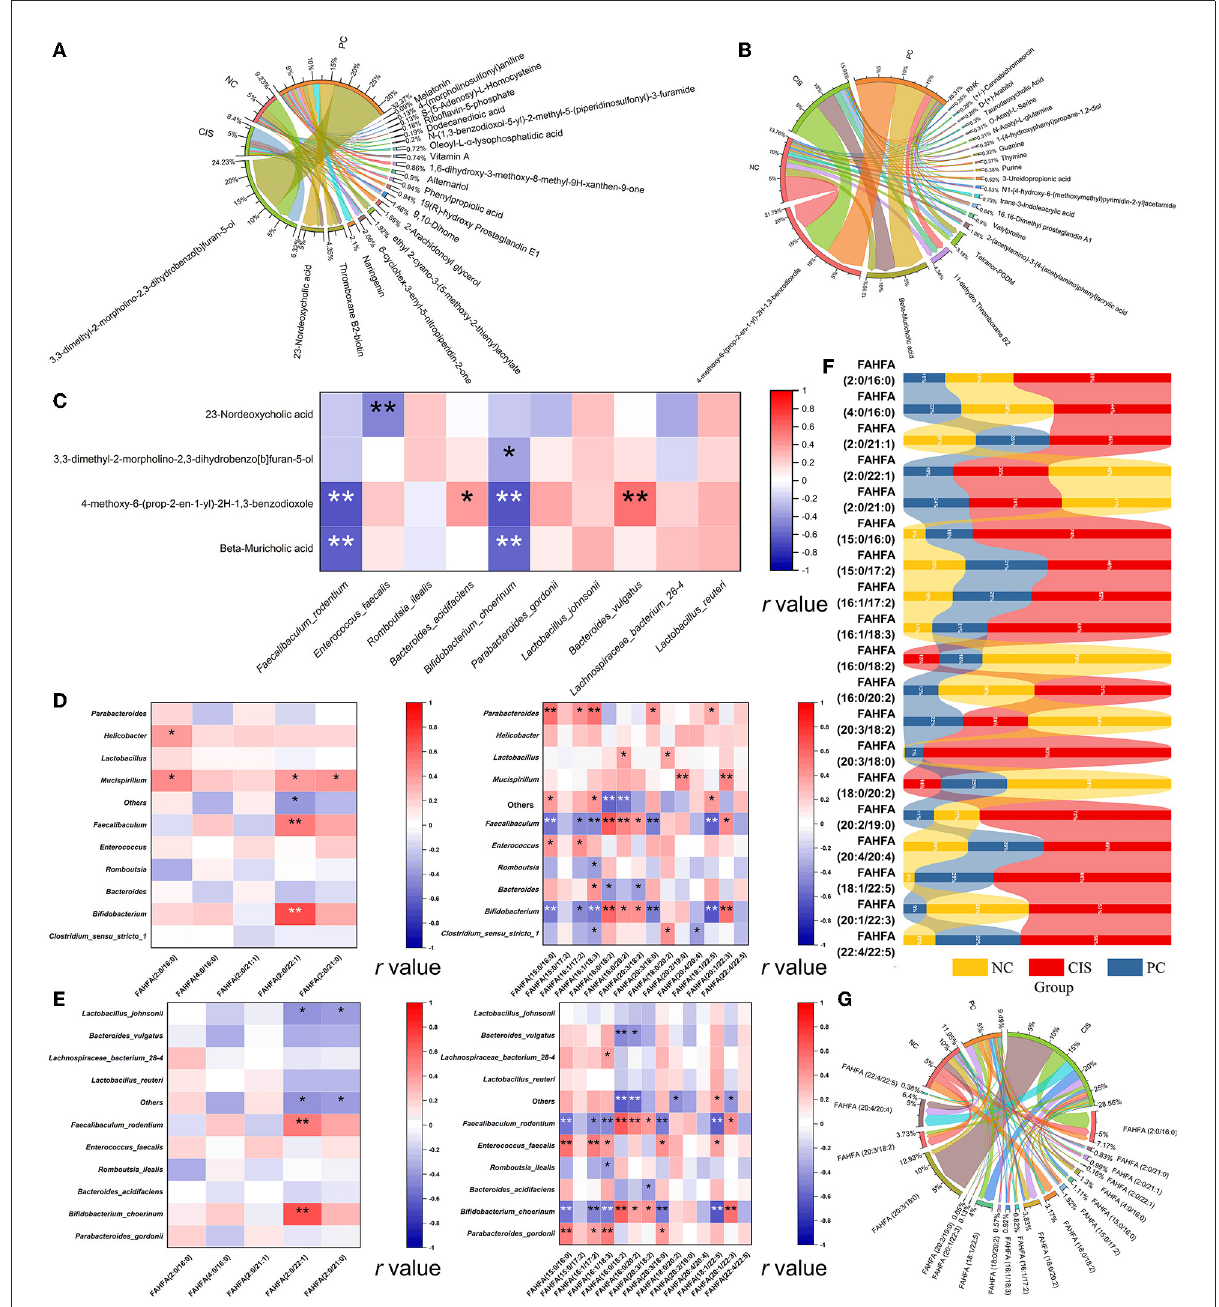
FIGURE6 Bile acid-related metabolites and FAHFAs levels in feces. (A) Chord diagram of metabolites which was significantly regulated by C-phycocyanin compared with the CIS group; (B) chord diagram of metabolites which was significantly regulated by cisplatin compared with the NC group; (C) Spearman correlation analysis between bile acid metabolites and the top 10 species abundance; (D) Spearman correlation analysis between FAHFAs contents and the top 10 genera abundances; (E) Spearman correlation analysis between FAHFAs contents and the top 10 species abundances; (F) strip chart of relative content of all FAHFAs; (G) chord diagram between each group and FAHFAs. NC, normal control; CIS, cisplatin; PC, cisplatin with C-phycocyanin; *, p < 0.05; ** p <